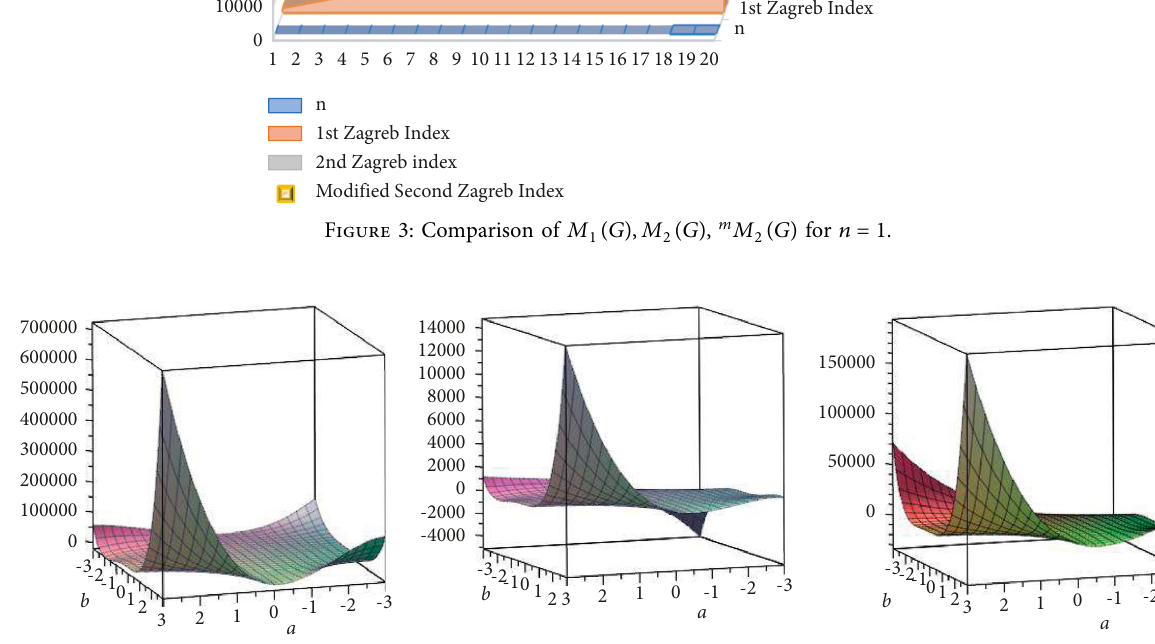
Figure 4: (a) R ( H ) for n � 1 , α � 1, (b) RR α